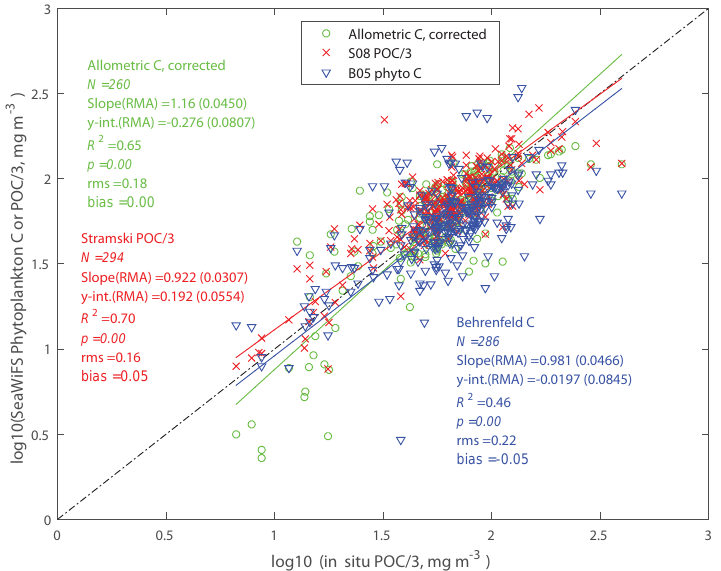
Figure 10. Validation of the total phytoplankton carbon satellite estimates discussed here, using SeaWiFS matchups of in situ POC measure- ments from the SeaBASS database. The three methods compared are: the allometric PSD method with the N o empirical correction applied (Sect. 3.7) (green circles and line), the S08 POC retrieval multiplied by 1 / 3 (red crosses and line) and the B05 retrieval (blue triangles and line). All available matchups are used, including those from shallow waters (<200m